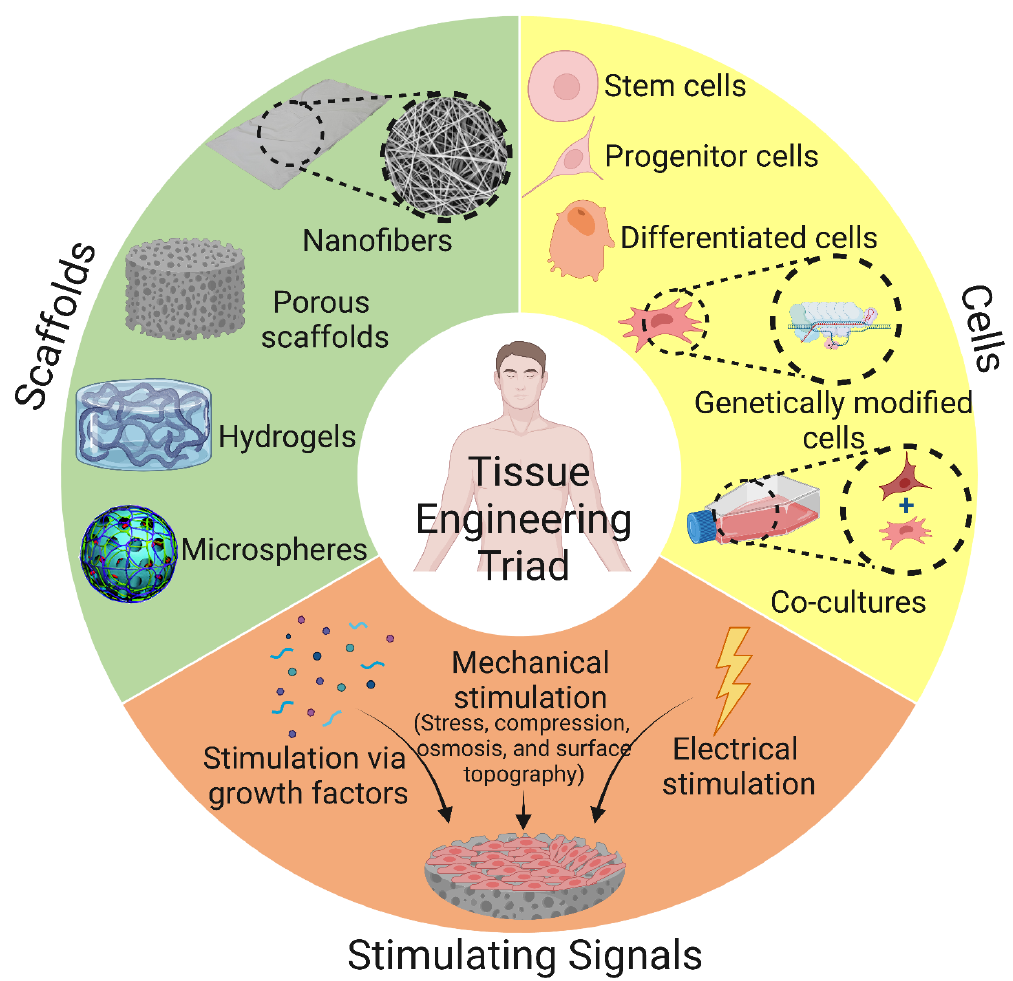
Figure 18. Tissue engineering (TE) triad comprising of three main components: cells, scaffolds, and stimulating signals. The image was created using Biorender.